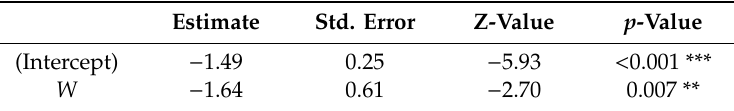
Figure 5. Modelled probability of having formed an intra-annual density fluctuation in the secondary xylem in 2014, depending on the adjusted relative extractable water in 2014. Table 5. Statistics from the logistic regression model with the absence / presence of an intra-annual density fluctuation in the secondary xylem of the first growing season as response variable. W : adjusted relative extractable water in